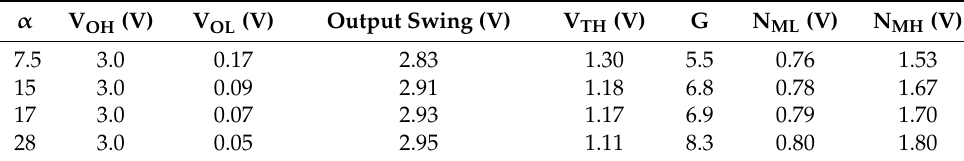
Figure 6. The static voltage transfer curve of the inverter with different α at V DD = 3V. Table 1. Noise margins for inverters with different α.